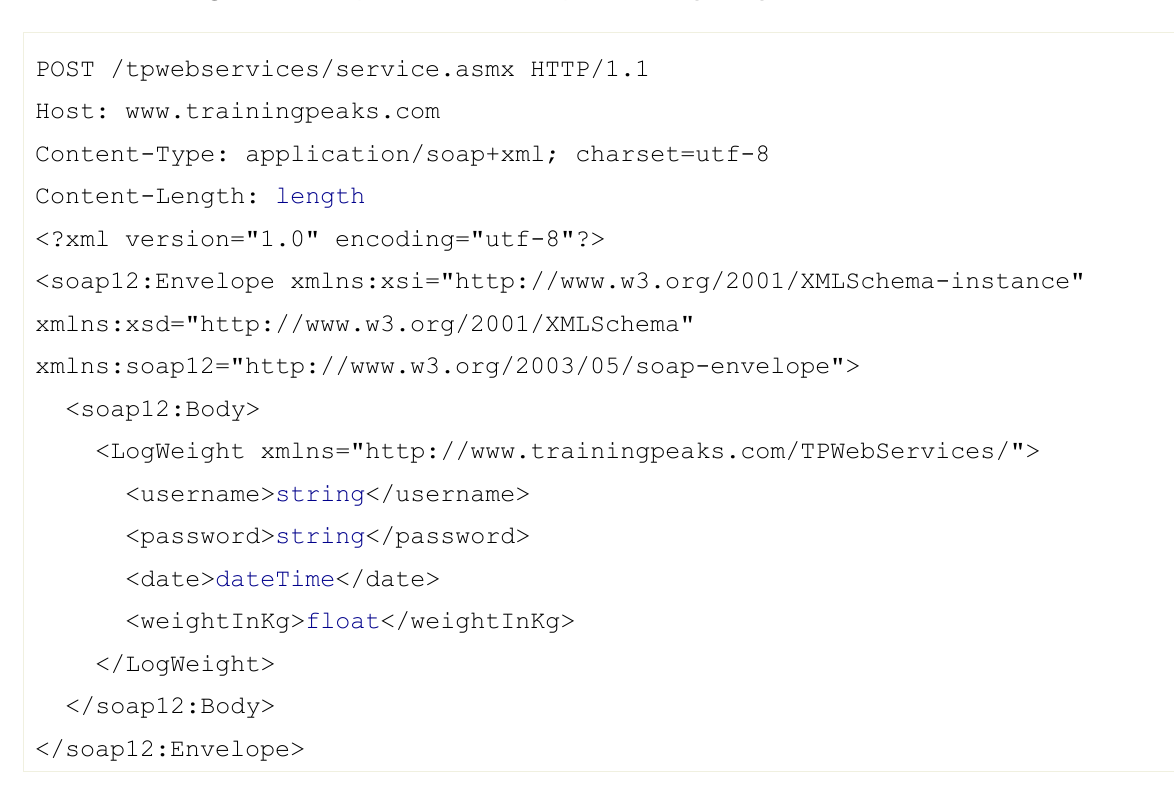
Figure 6. Sample SOAP 1.2 request of LogWeight web